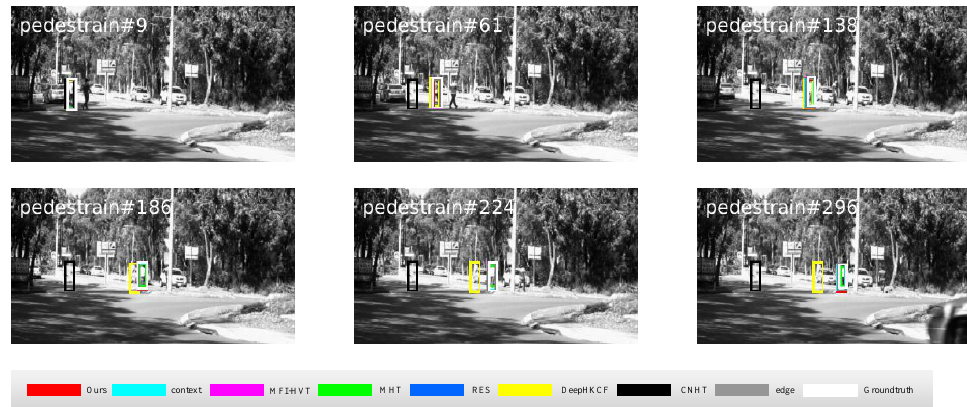
Figure 13. Qualitative outcomes for the pedestrian